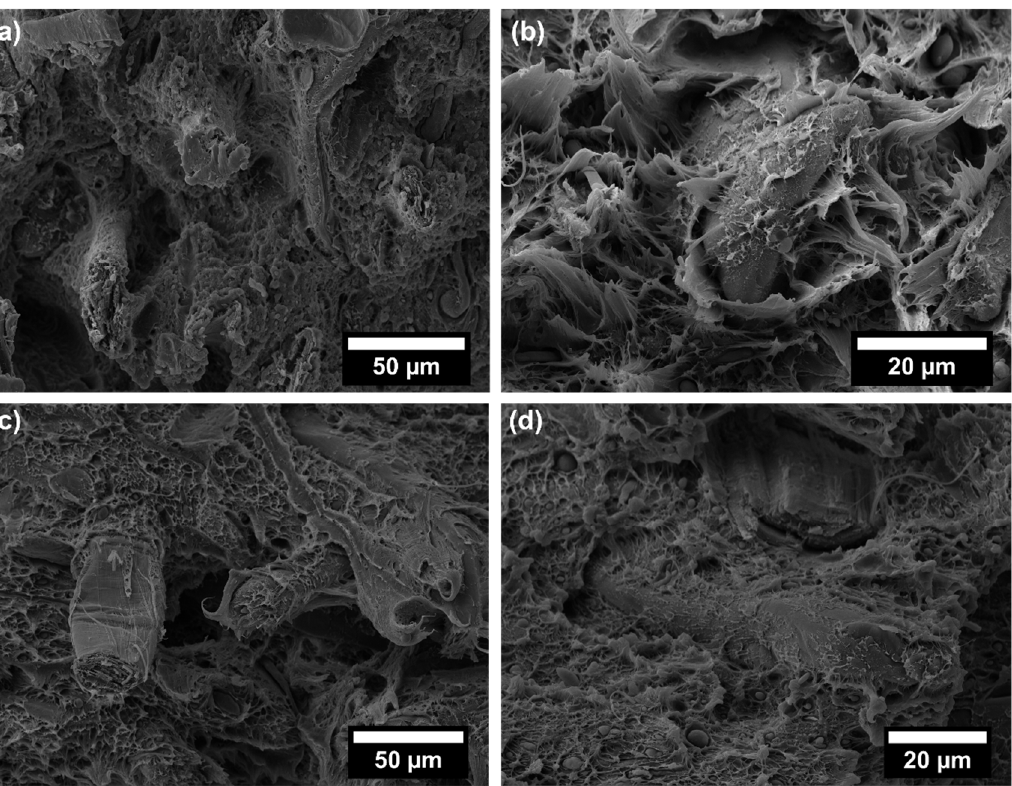
Figure 7. SEM micrographs of EcoAl_30F + CA: ( a , b ) after tensile test; ( c , d ) after Charpy impact test.